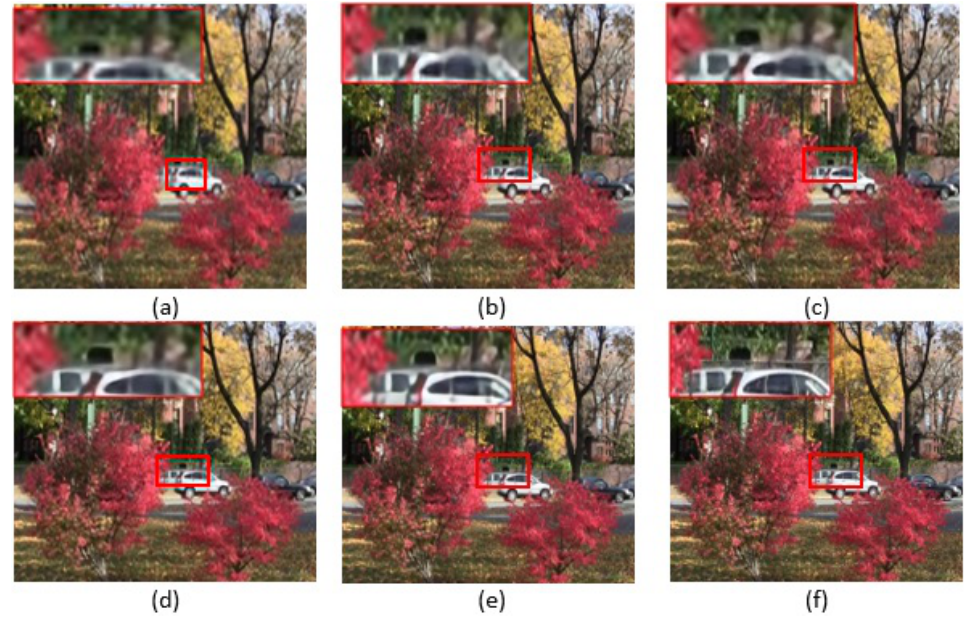
Figure 5. Qualitative comparison between VSR results obtained by ( a ) Bicubic, ( b ) VSRNET [24], ( c ) SRCNN [16], ( d ) VESPCN [27], ( e ) Proposed and ( f ) Ground-Truth on “ foliage ” from Vid4 with scaling factor of